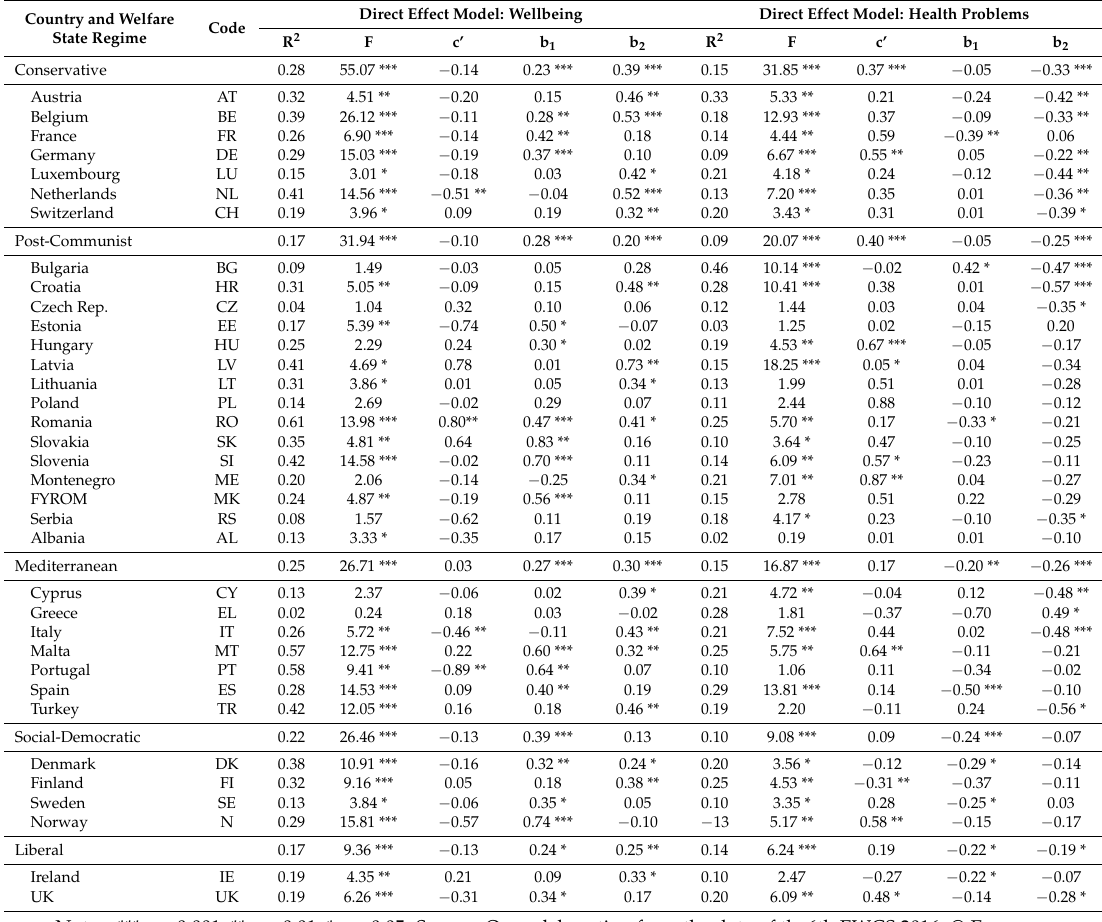
Table 3. Direct effect models to explain psychological well-being and health problems, on the basis of gender, basic needs, and satisfaction with work conditions, by country and by welfare state regime. Country and Welfare State